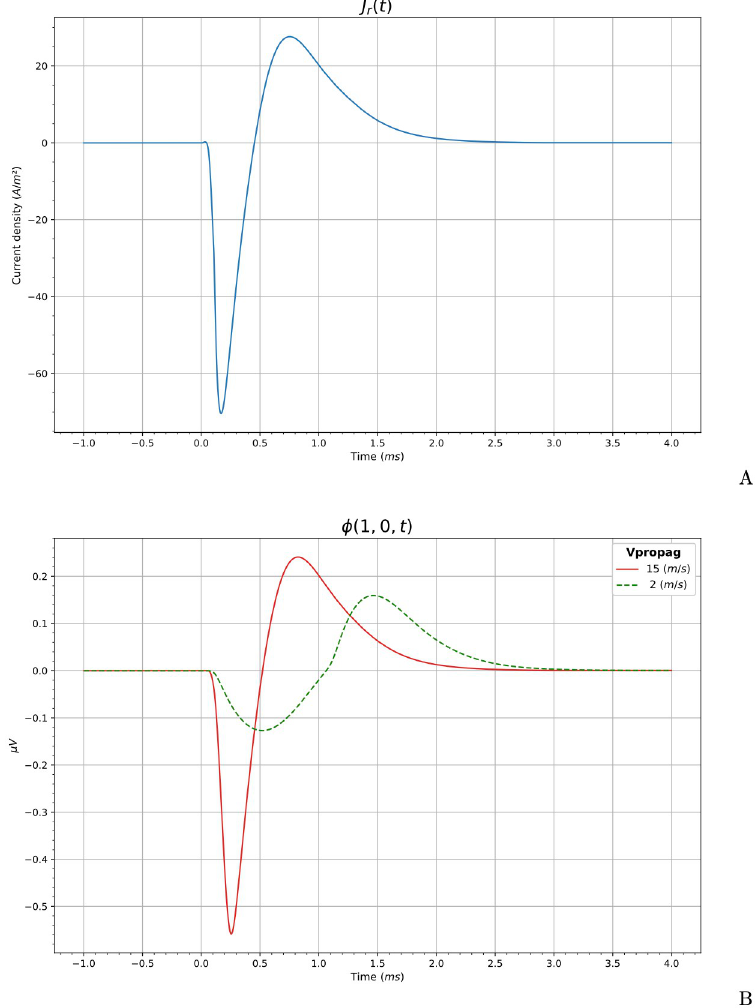
Fig 4. Membrane current density and extracellular potential. This figure shows the membrane current generated in an ANF, used as input in our model (A). Extracellular potentials calculated for an academic example at r = 1 mm and z = 0 mm corresponding to velocities of propagation of 2 m s − 1 (dashed green) and 15 m s − 1 (red) are shown in